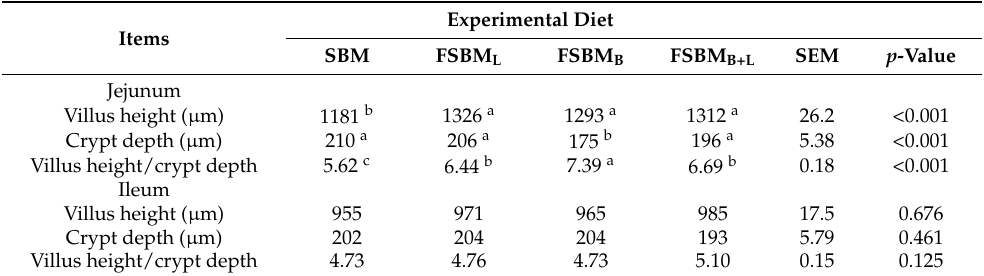
Figure 3 . Effect of two-stage FSBM on Jejunum ( a ) and ileum ( b ) intestinal morphology of 35 day-old broilers. SBM: Soybean meal; FSBM L : commercial control; FSBM B : SBM one-stage fermented by Bv; FSBM B+L : SBM two-stage fermented by Bv and Lb. Table 4. Effect of two-stage FSBM on intestinal morphology of 35 day-old broilers 1.